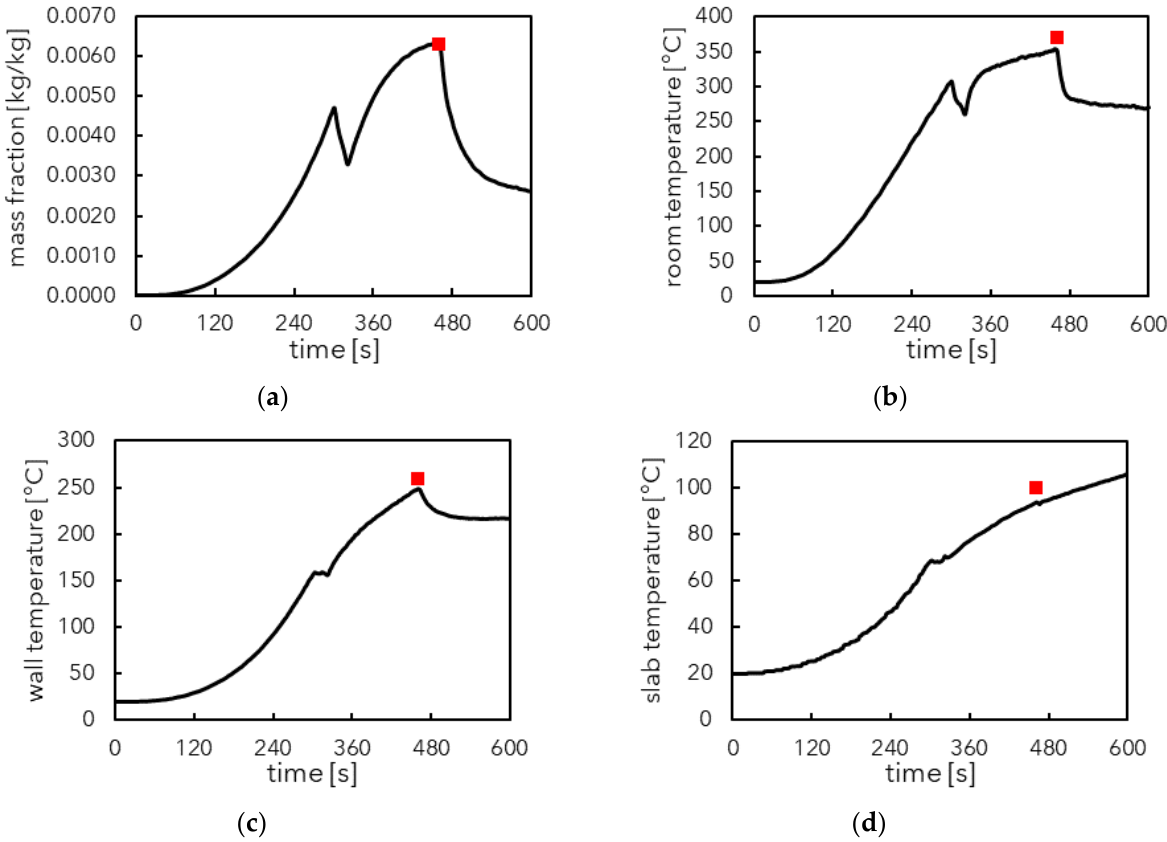
Figure 2. Results for established timeline, spatially-averaged for the full apartment volume: ( a ) soot mass fraction; ( b ) room gas temperature; ( c ) wall/ceiling temperature; and ( d ) slab temperature. Red marker rounded to nearest 10 °C for ( b – d ). Table 4. Descriptive statistics for the established timelines, recorded by devices for the entire initial region or boundary condition.